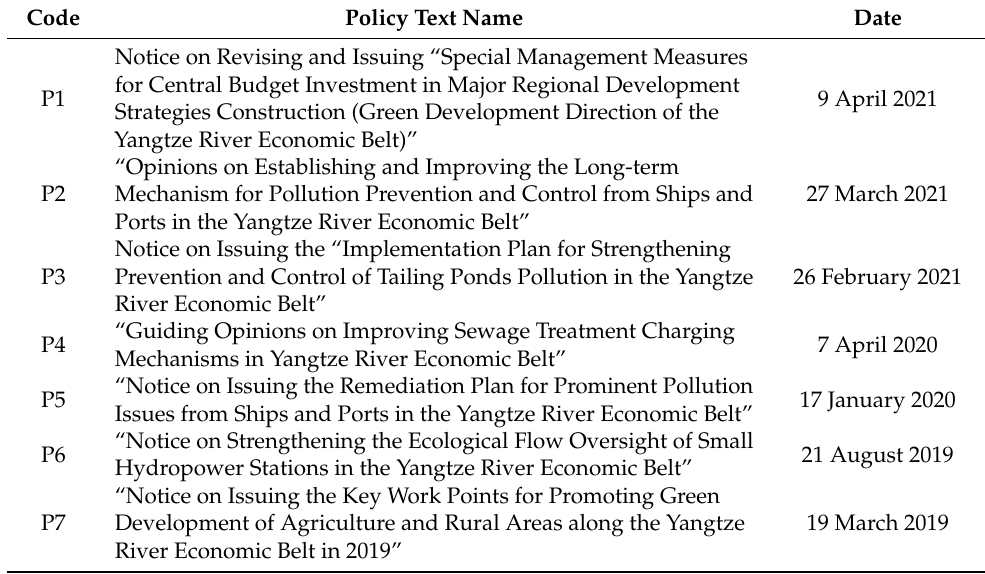
Table 1. Policy texts